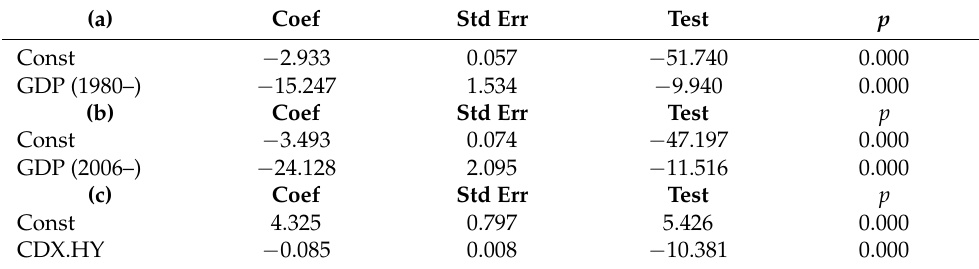
Table 5. Rating B: model parameter estimates and p